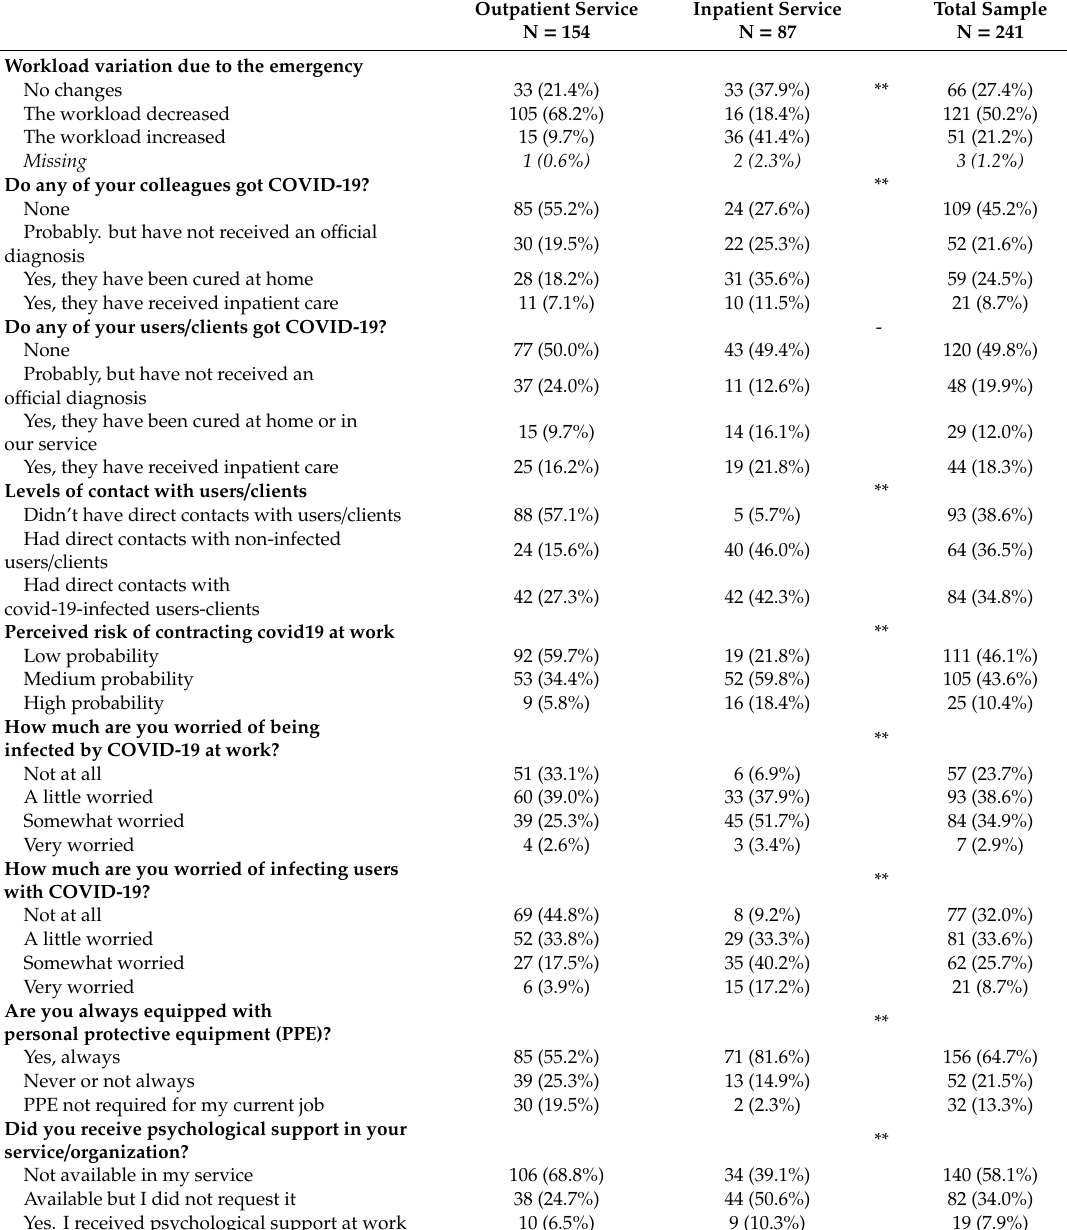
Table 2. Mental health workers’ work conditions during the COVID-19